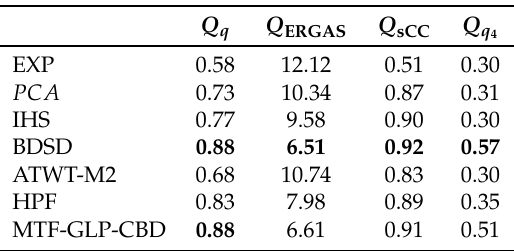
Table 8. IKONOS Roma Coliseum scene, reduced resolution quantitative results. The bold number indicates the best performing PS method according to each quality